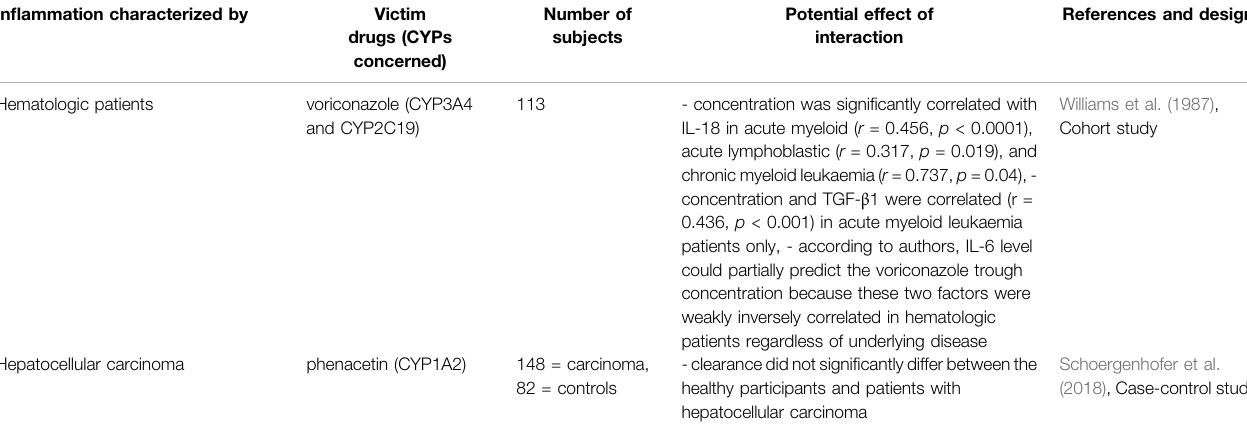
Table 13 . As an example, IL-2 doses of 9 – 12 × 10 6 units daily may downregulate CYP activities in patients with HIV infection and cancer in